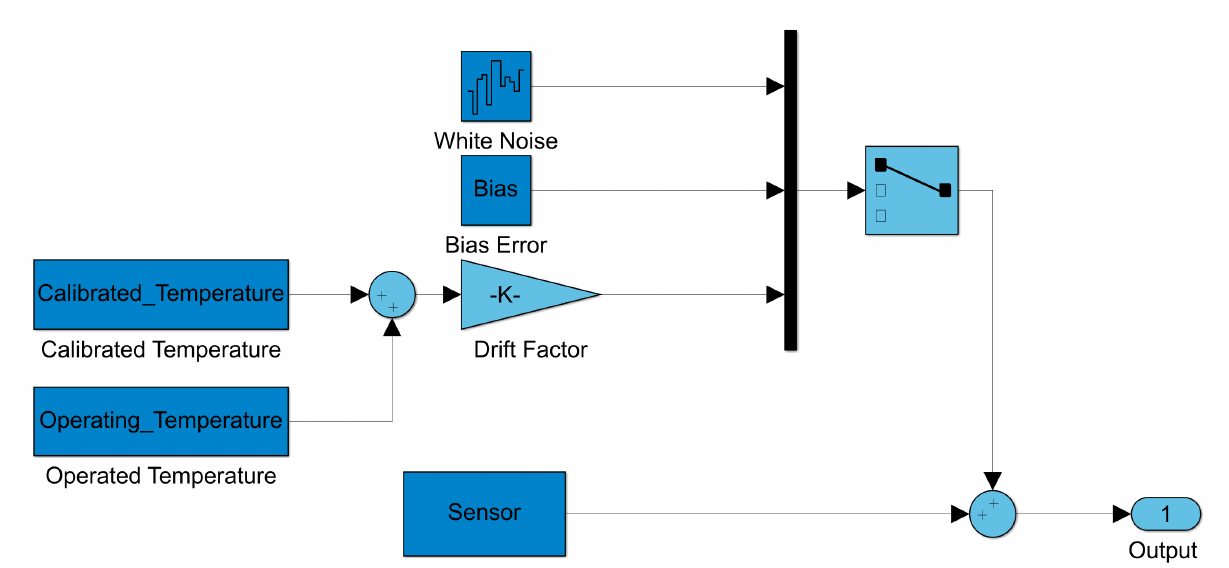
Figure 4. Measurements from gyroscopes with white noise. Figure 5. Modelling the sensor errors. Figure 5. Modelling the sensor